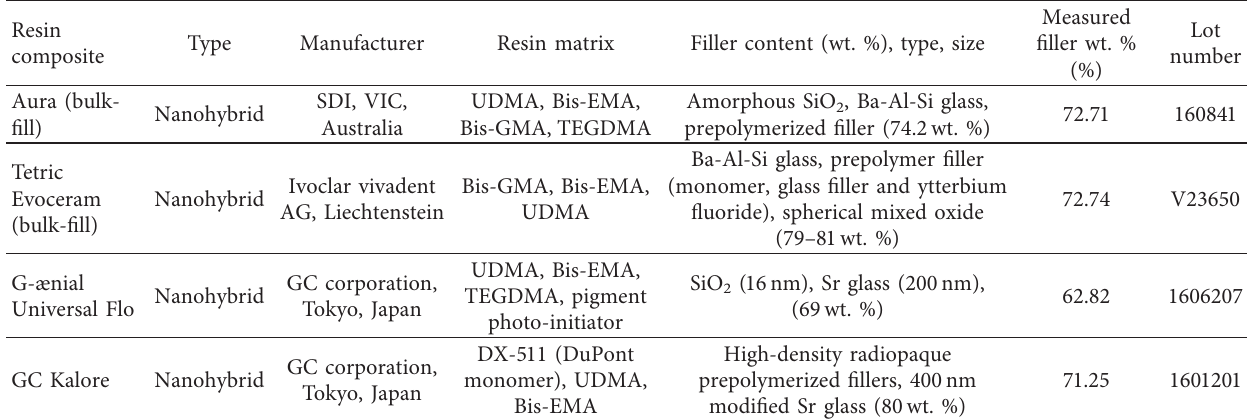
Table 1: Description of all the resin composites used in the study and filler weight (%) measured by the ash method. Resin Type Manufacturer Resin matrix Filler content (wt. %), type, composite